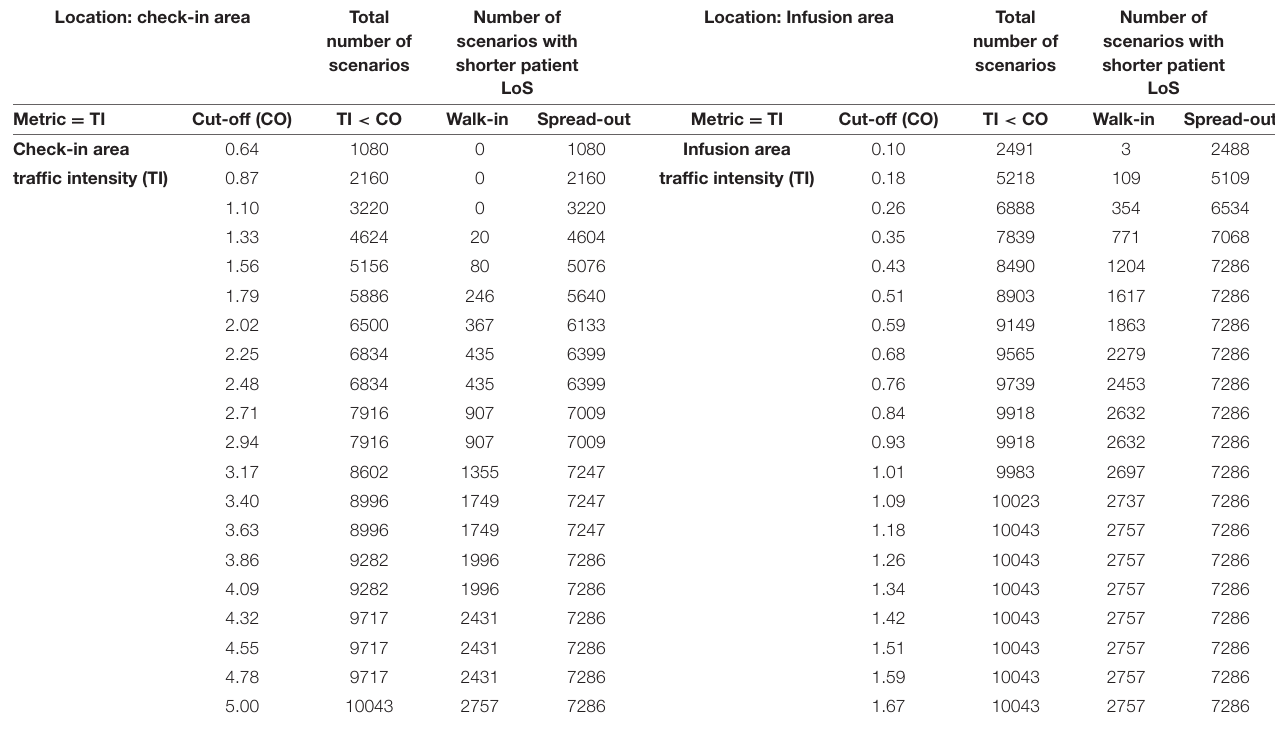
TABLE 4 | Number of scenarios with shorter LoS under walk-ins and spread-out